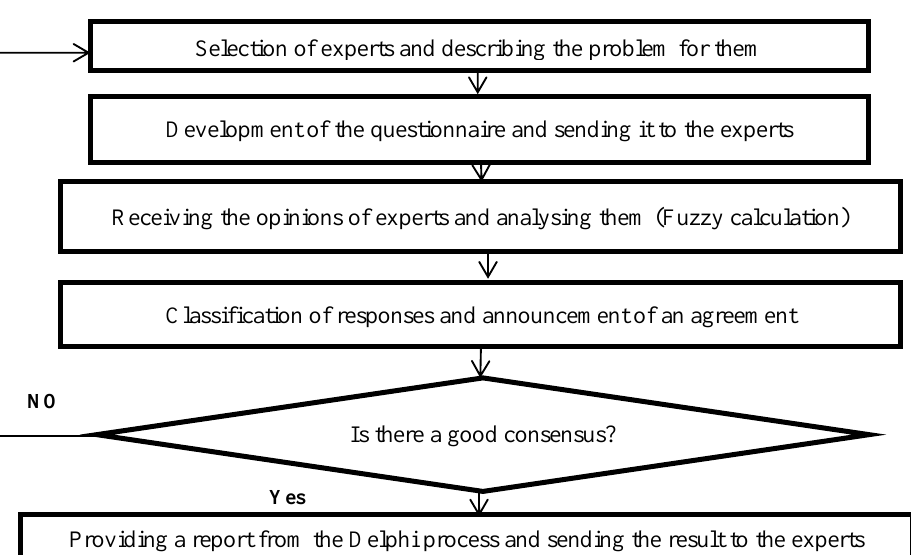
Figure 1. Algorithm for implementation of Fuzzy Delphi